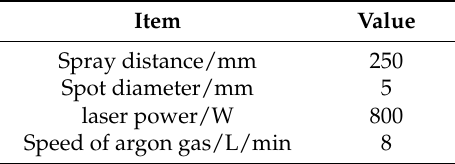
Table 1. Technological parameters of cold sprayed Al